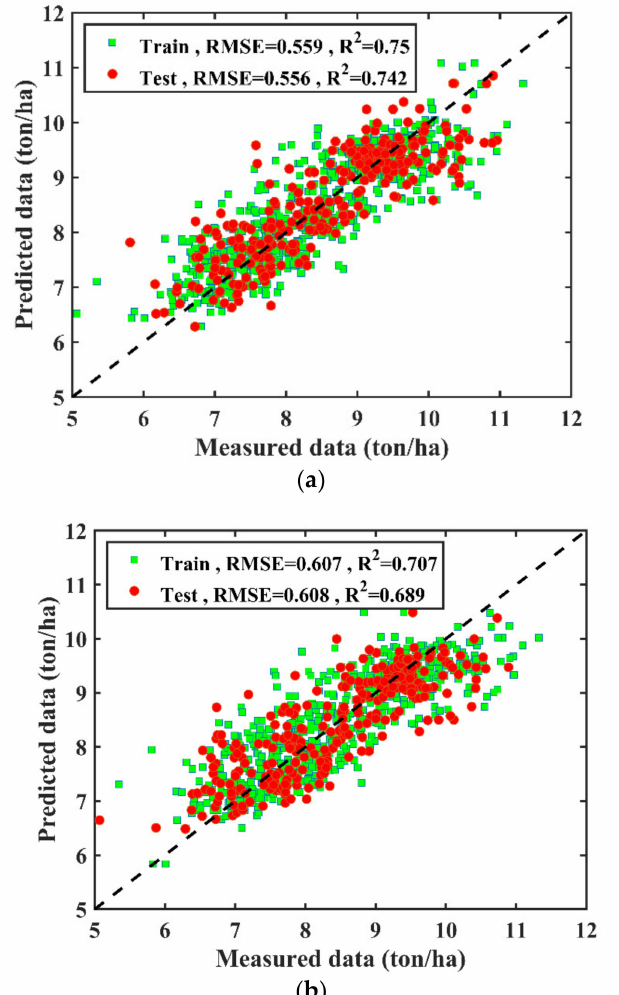
Figure 5. ( a ) Performance of PLSR model with optimized PLS factor of 4 for training and testing sets using agronomic traits data; ( b ) Performance of FFBN model with optimized neurons of 10 in hidden layer for train and test set using agronomic traits